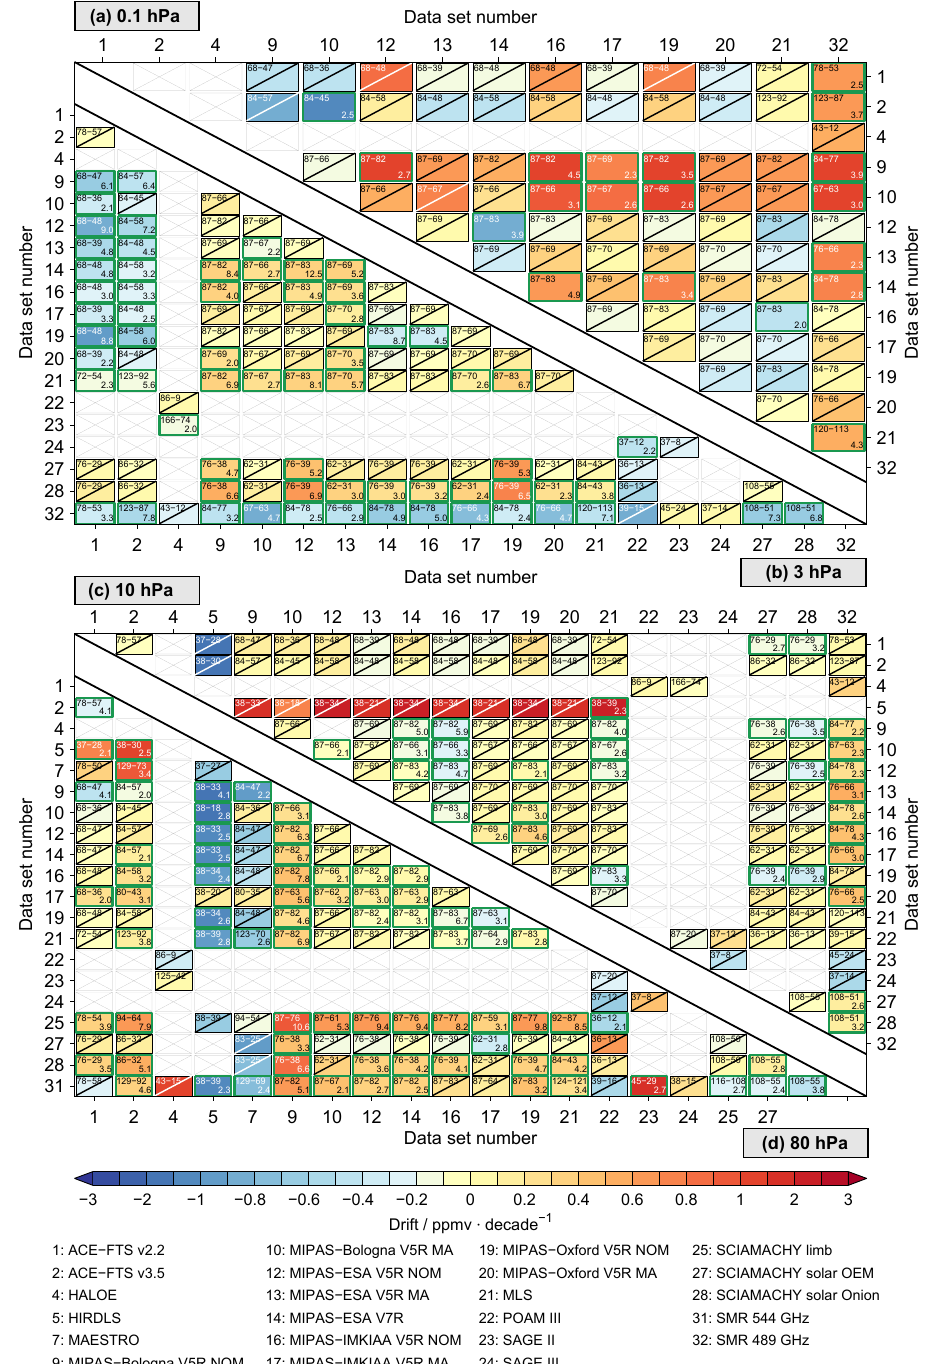
Figure 13. As Figs. 11 and 12, but here the results for the latitude band between 50 ◦ and 60 ◦ N are shown.